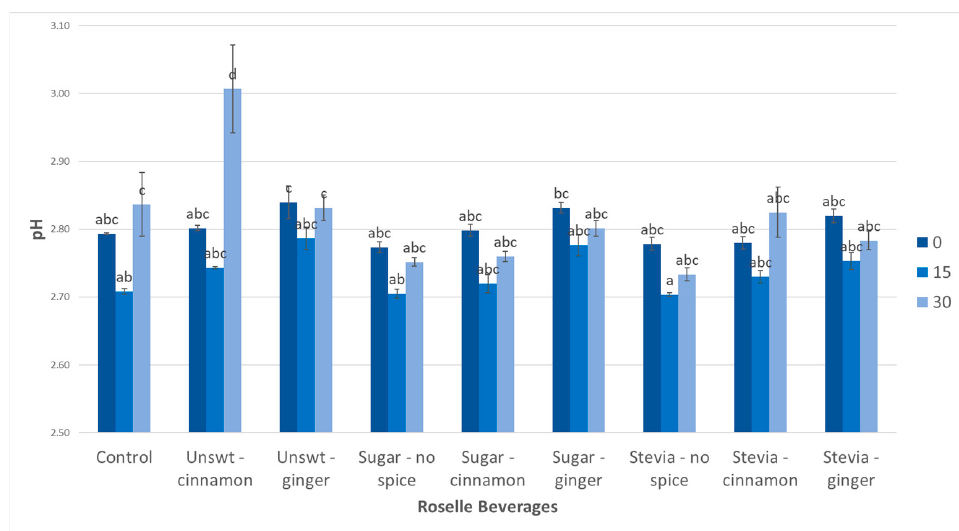
Figure 5. The pH profile of the unsweetened or sweetened Roselle beverages (with sugar or Stevia Reb A) and unflavoured or flavoured (with cinnamon or ginger) on days 0, 15, and 30 of the accelerated storage at 40 °C. Each bar/point represents mean values + SD. Symbols a–d denote the level of differences between treatments.